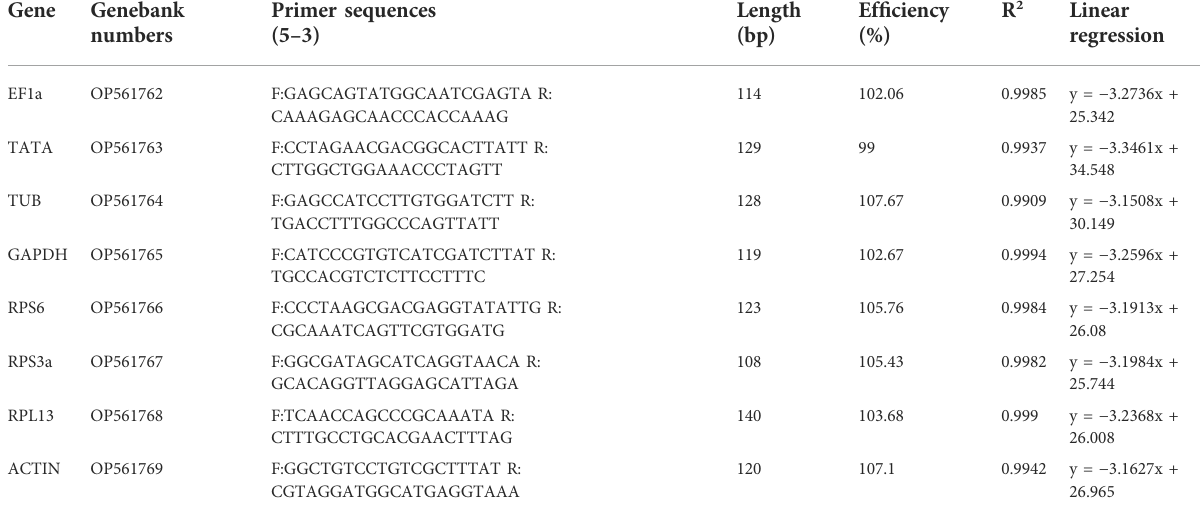
TABLE 1 Primers and amplicon characteristics for the selected reference gene